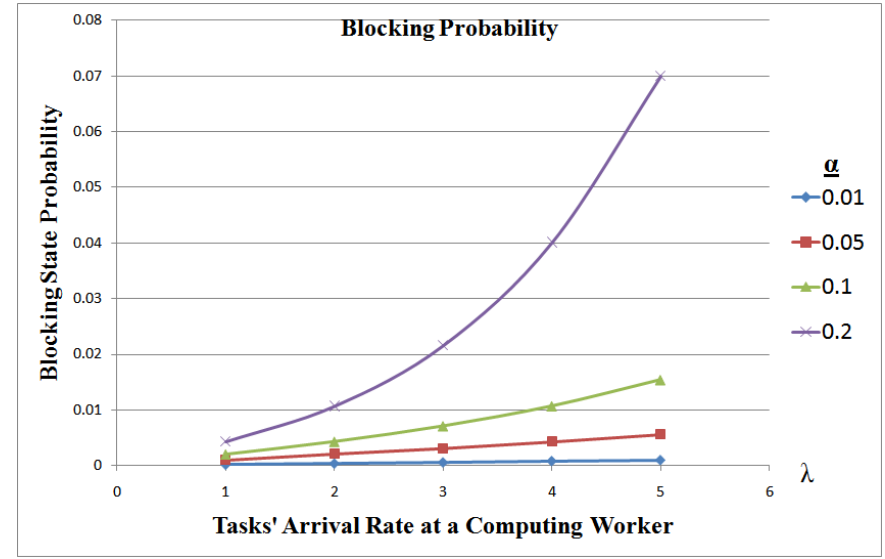
= (cid:22) = (cid:22) . 1 ;r 2 ;r 3 ;r